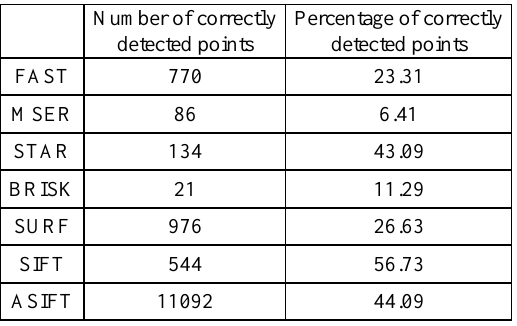
Table 3 Number and percentage of correctly detected